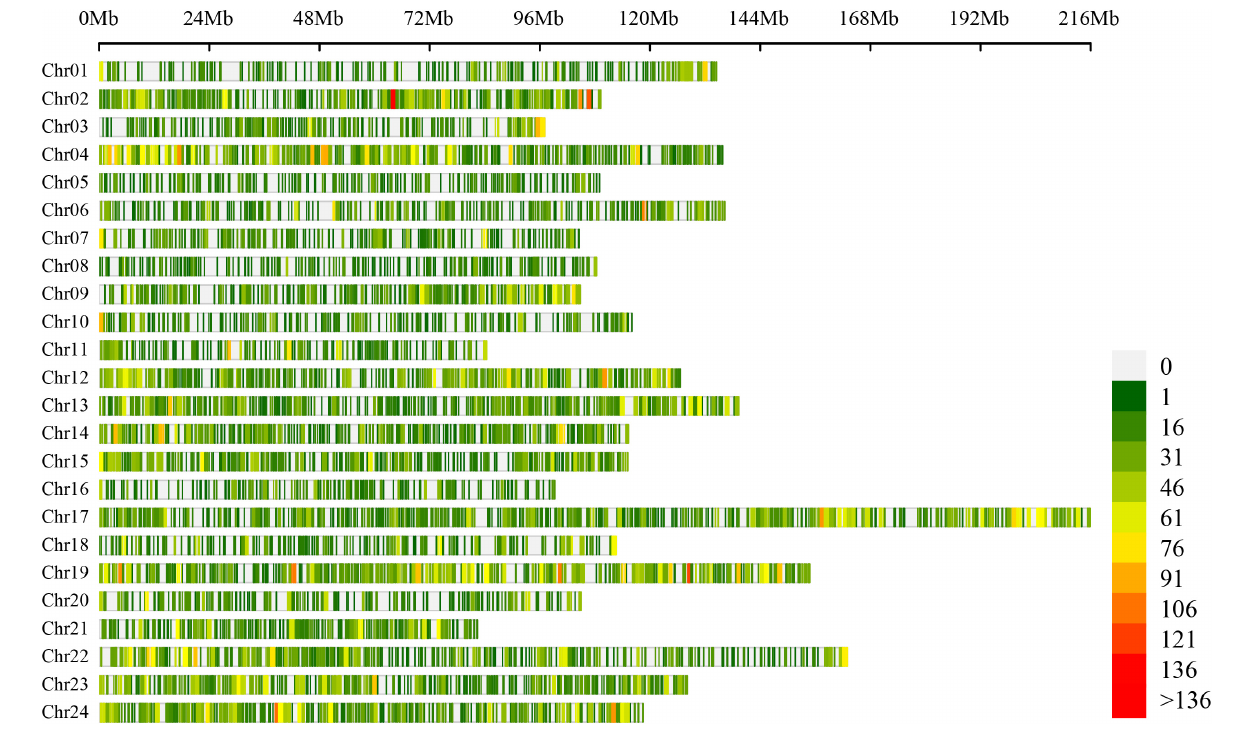
(Qiagen, Germany) according to the manufacturer’s